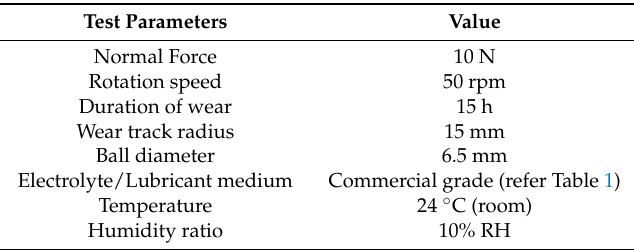
Table 2. Test parameters of the tribo-corrosion